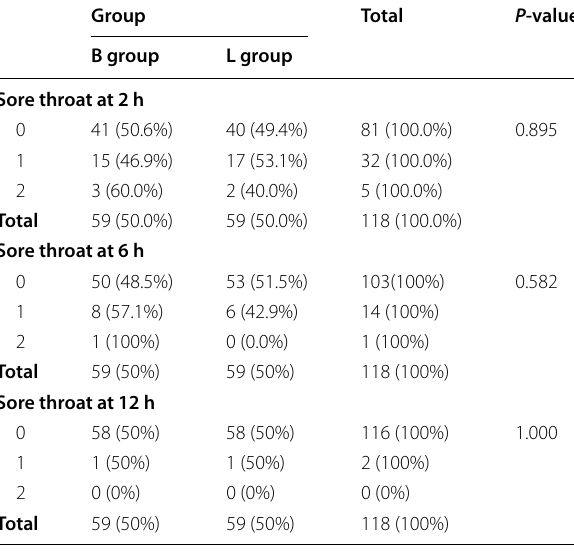
Table 3 Significance of postoperative sore throat at 2, 6, and 12